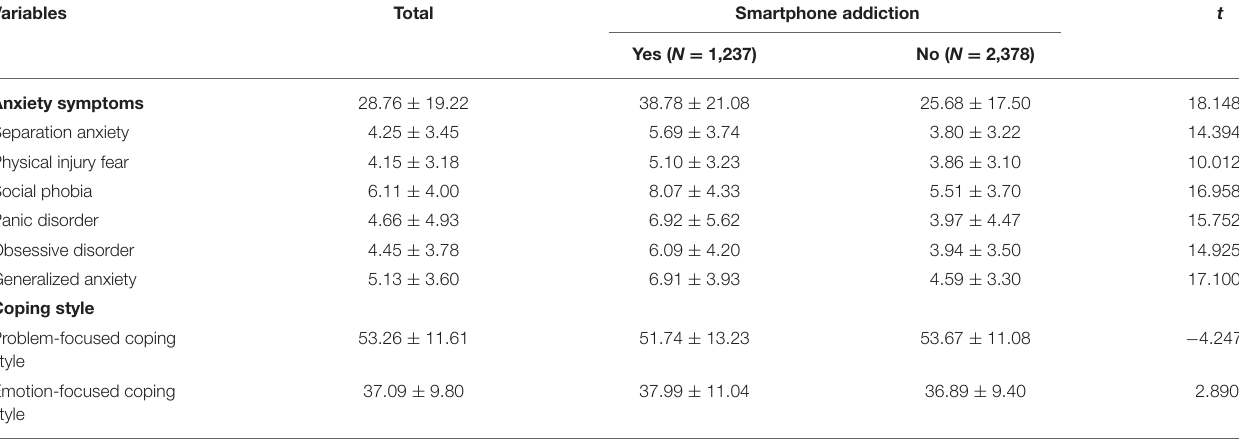
TABLE 3 | Means, standard deviations on anxiety and coping style for smartphone addiction and